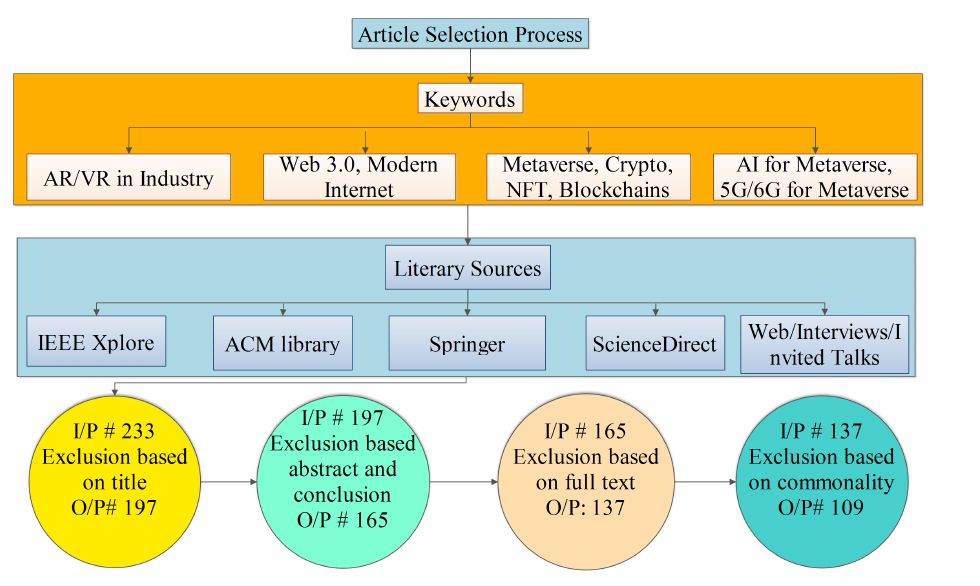
Figure 2. Article selection and inclusion–exclusion